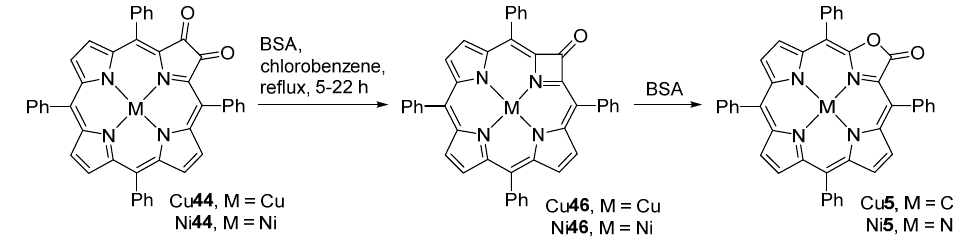
Table 1. Yields of the oxidation of 2,3-dioxochlorins M 44 under different conditions 1 .